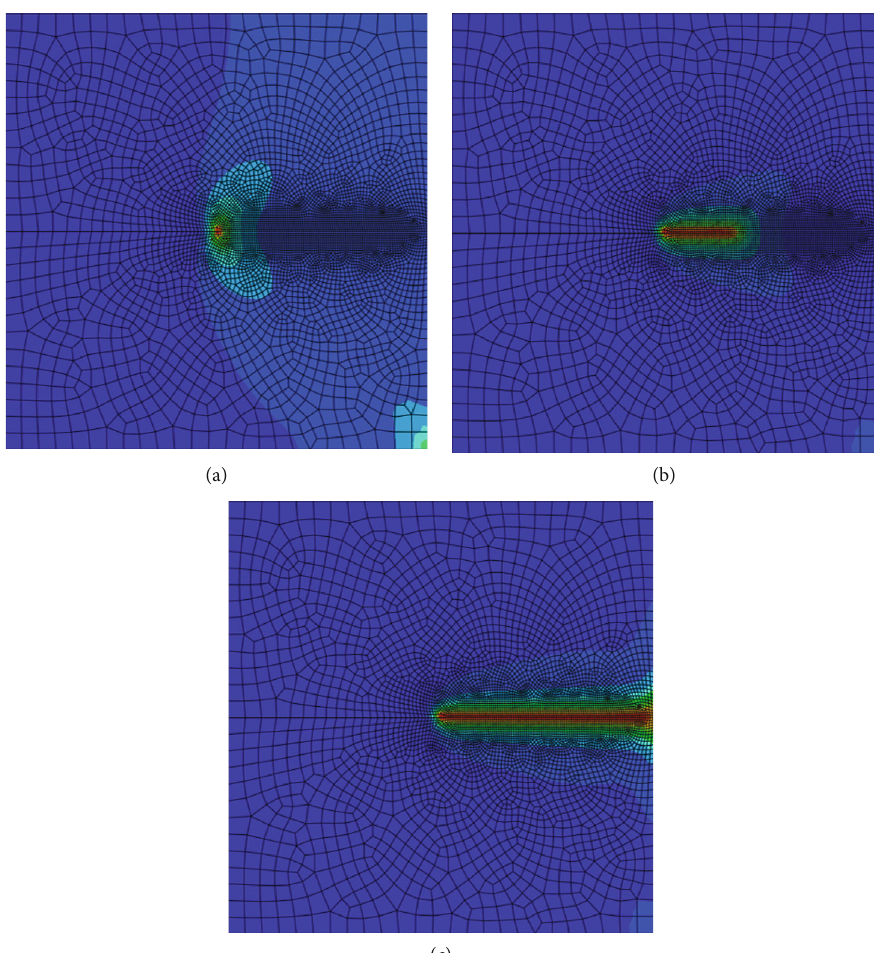
Figure 4: The propagation of crack when l = 0 : 015mm . (a) Crack initiation stage. (b) Crack development stage. (c) Crack penetration